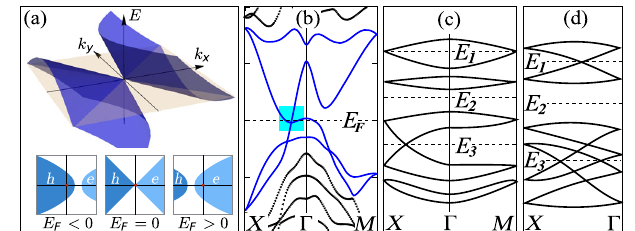
FIG. 1. (a) A Dirac fermion that tilts over. (b) Band structure of a WTe 2 monolayer without spin-orbit coupling; the tilted Dirac fermion is highlighted by a blue square. (c) Band structure of a nonsymmorphic, spin-orbit-free crystal at various fillings. (d) Band structure of a nonsymmorphic, spin-orbit-coupled crystal at various fillings. For both (c) and (d), E 1 , E 2 , E 3 are Fermi energies that, respectively, exemplify (1) a semimetal whose metallicity originates from its filling, (2) a generic insulator, and (3) a topological semimetal whose metallicity originates from a band